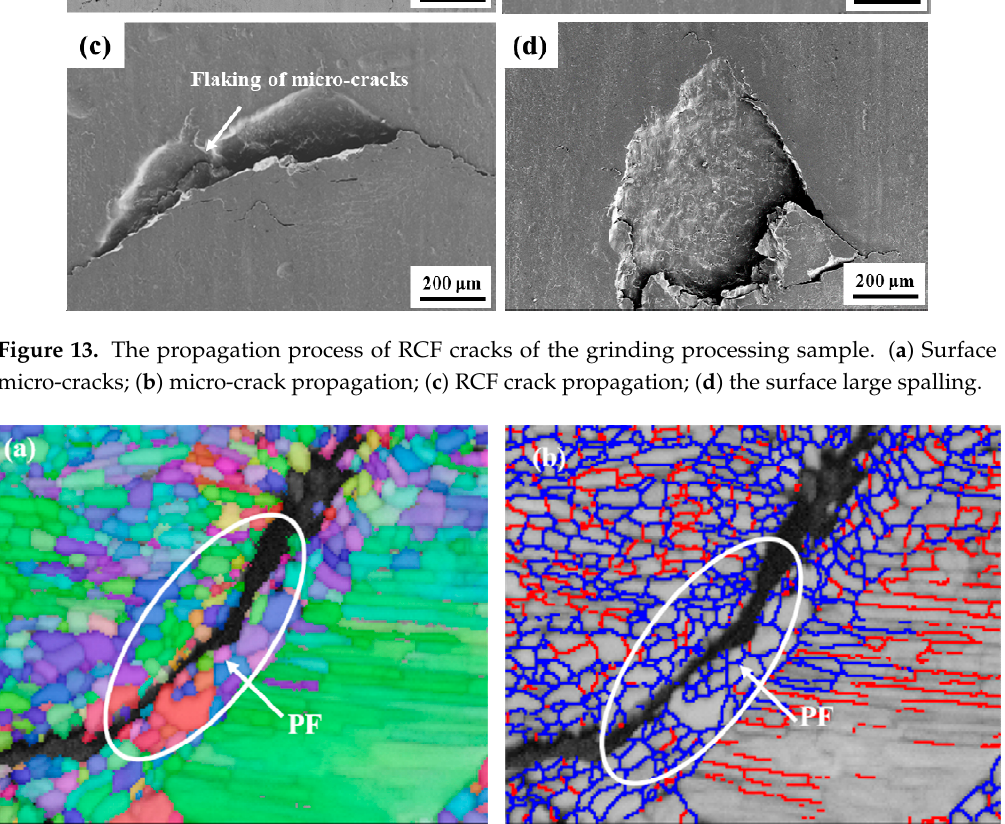
Figure 15. The EBSD micrographs of propagation of RCF cracks at the interface between proeutectoid ferrite and pearlite (red lines: 2° < θ <10° ; blue lines: θ > 10°; “PF” is an abbreviation of proeutectoid ferrite). 4. Discussion Figure 16a shows the formation process of RCF cracks of the grinding processing sample. After grinding, a certain thickness of grinding fine-grained layer was formed after grinding processing.